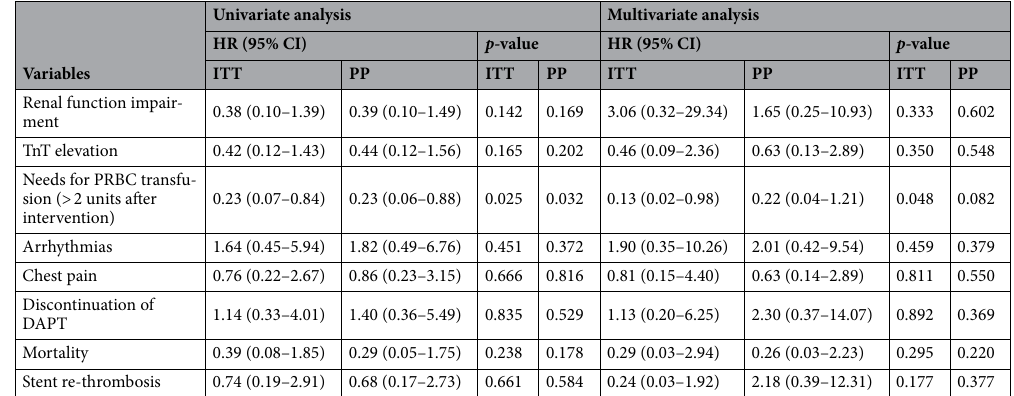
Table 3. Logistic regression analysis to evaluate the outcomes after early endoscopy (adjusted by age, sex, body mass index, smoking status and each parameter). DAPT dual antiplatelet agents, HR hazard ratio, PRBC packed red blood cell, TnT